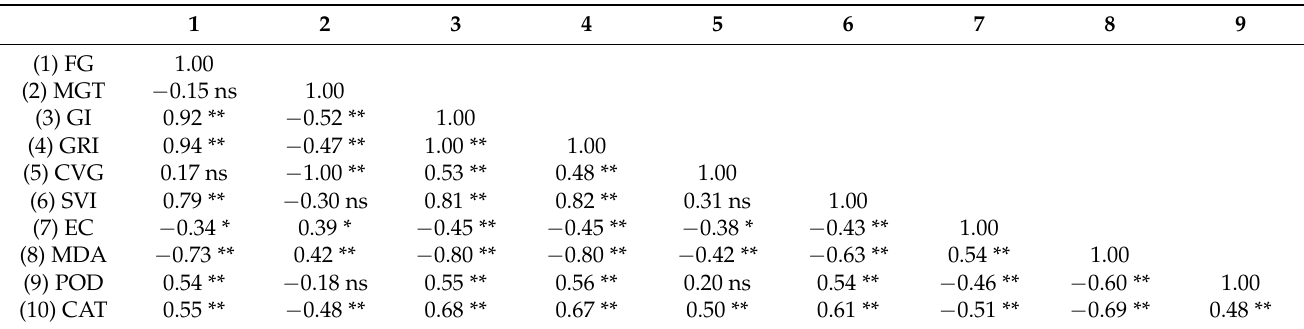
Table 7. Pearson correlations for seed and seedling quality parameters of sand germination test with different priming treatments.